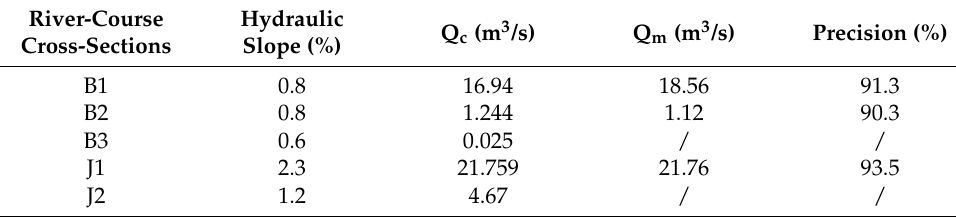
Table 3. Flow rate estimation of river cross-sections.